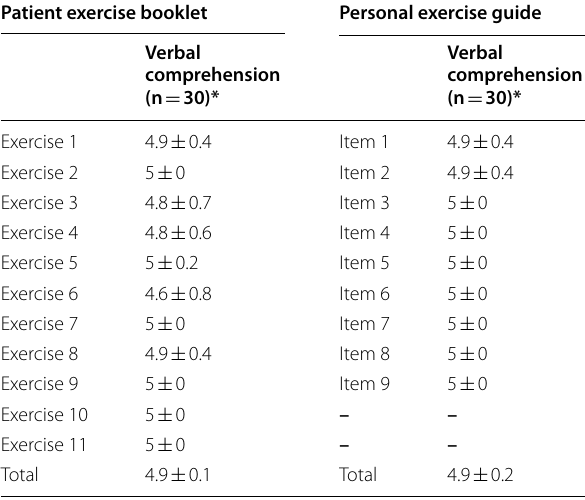
Table 2 Verbal comprehension assessment of the patient exercise booklet and personal exercise guide by women with RA